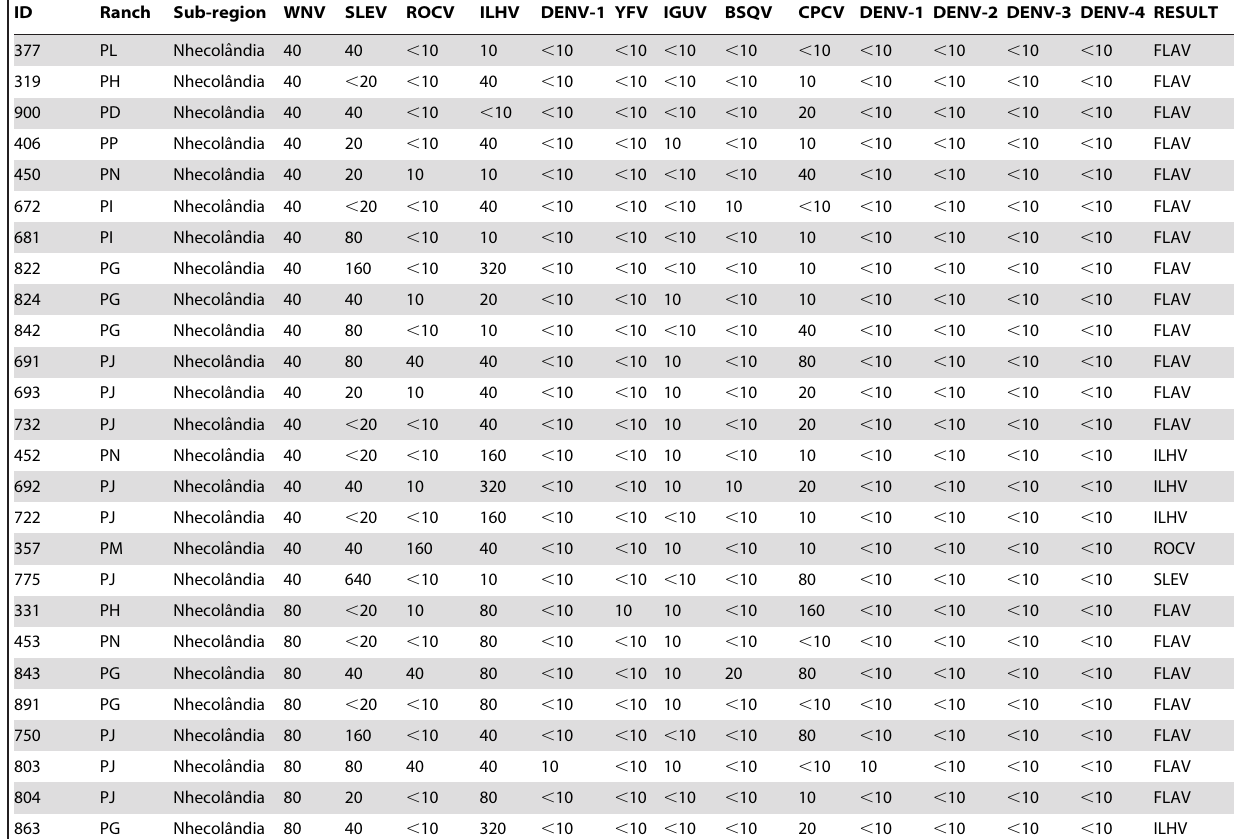
Table 3. PRNT 90 titers in WNV-seronegative equines that had titers $ 40 for WNV.